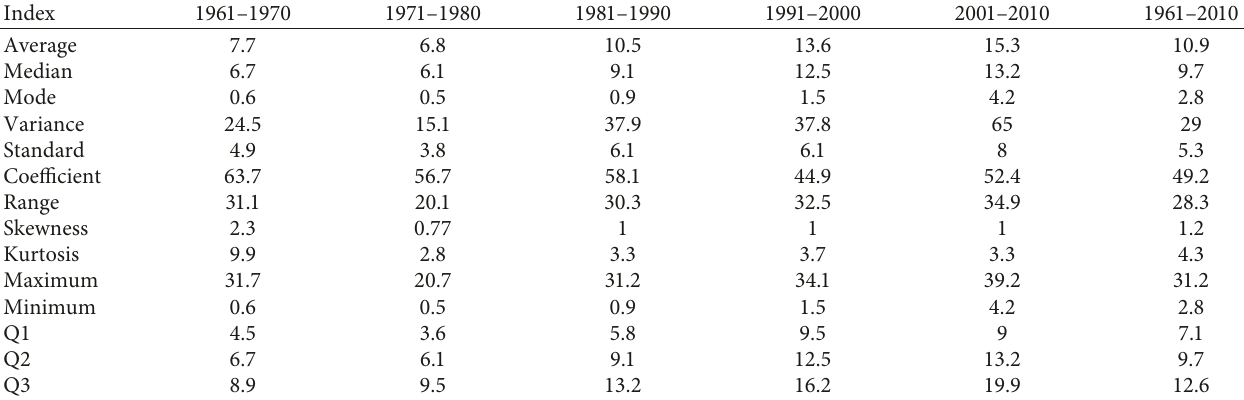
Table 2: Spatial features of the frequency of Iran’s thunderstorms for different